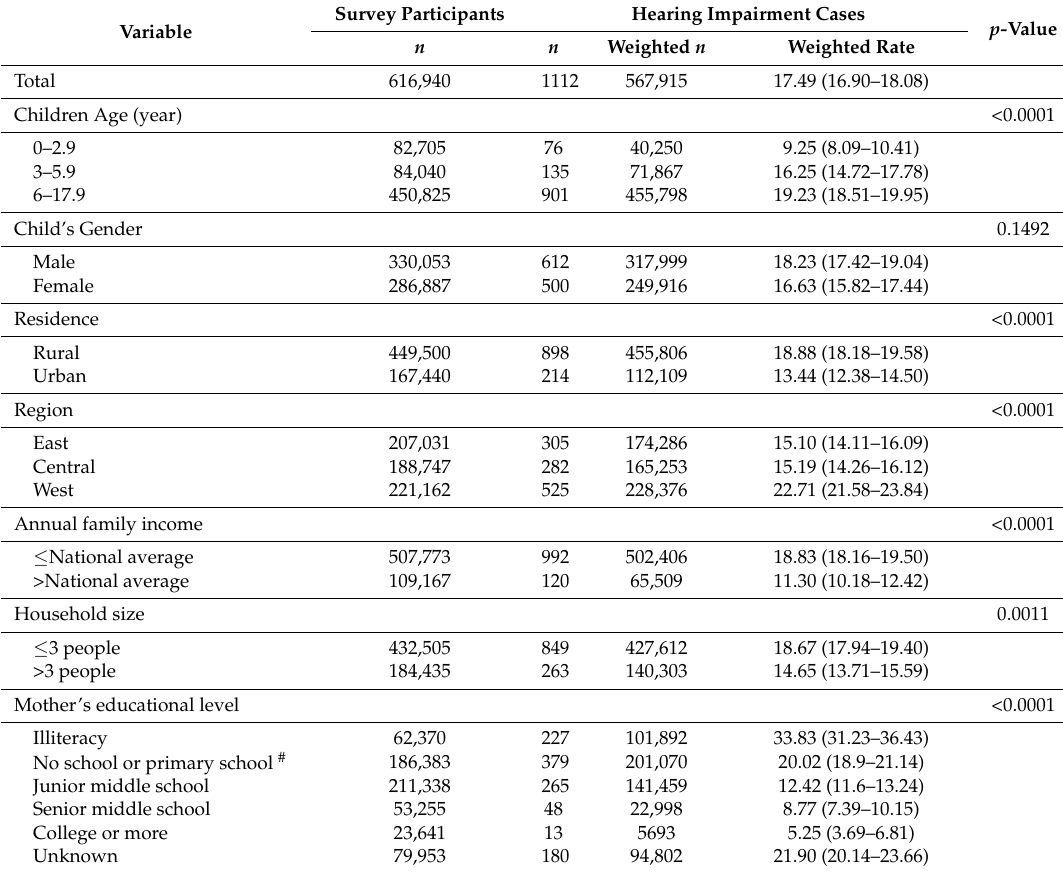
Table 1. Prevalence rate of hearing impairment among Chinese children (per 10,000 people). Survey Participants Hearing Impairment Cases Variable